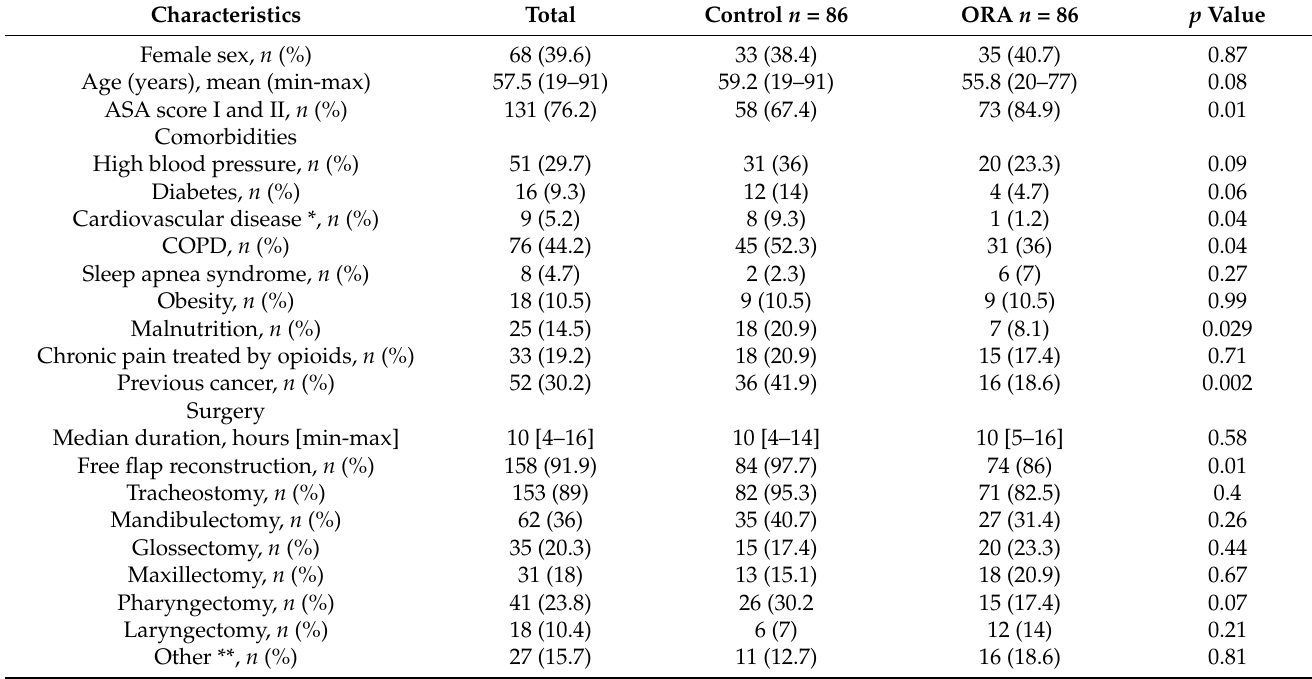
Table 1. Baseline characteristics of